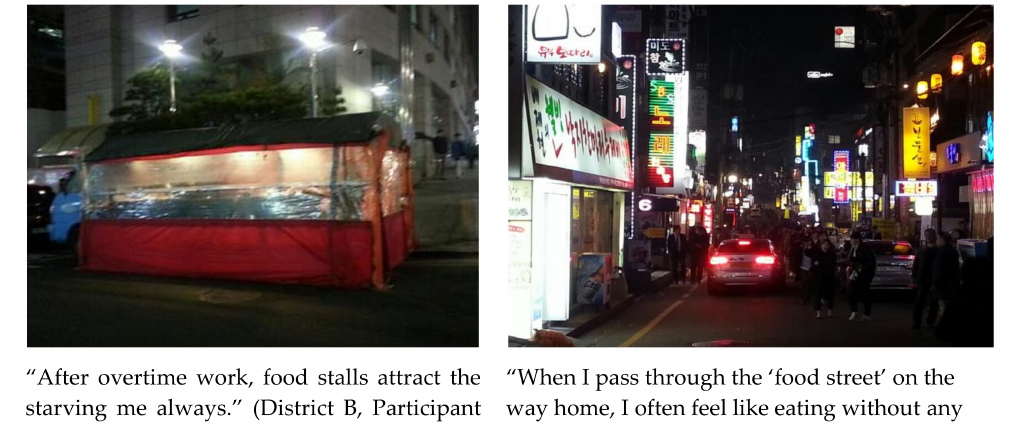
Figure 4. Pictures and statements depicting a food stall and a food street.